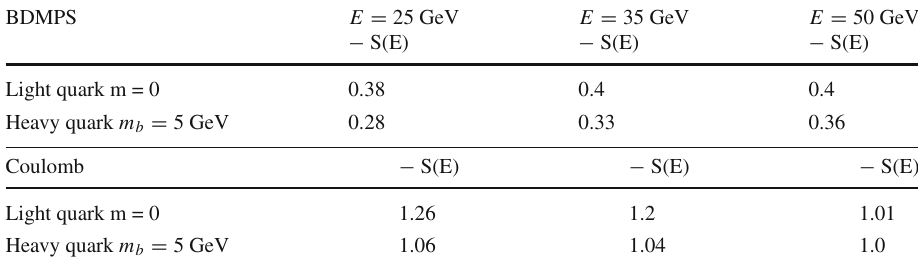
Table 2 The estimate for quenching coefficients S(E) for light and heavy quarks, for L = 4 fm widths. The jet quenching factor Q ( E ) = exp ( S ( E )) . Here α = 0 . 3 , C = 4 / s F